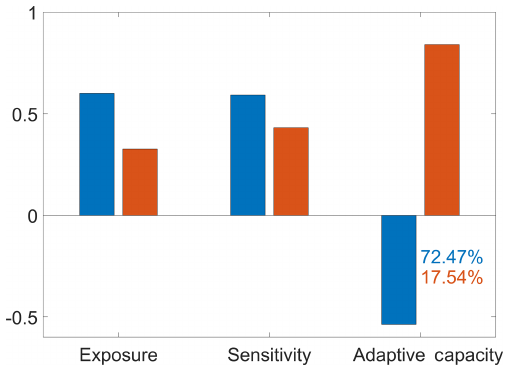
Figure 8. Loading factors of each PC (PC 1 – blue; PC 2 – orange) of exposure, sensitivity and adaptive capacity shown in Fig. 5. The percentage of variance explained for each PC is presented in bottom right corner.